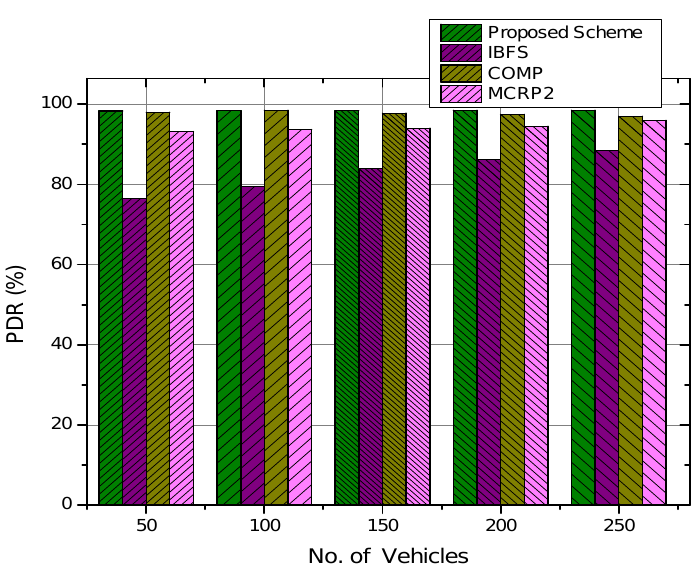
Figure 7. Packet Delivery Ratio of Multihead Selection Scheme.